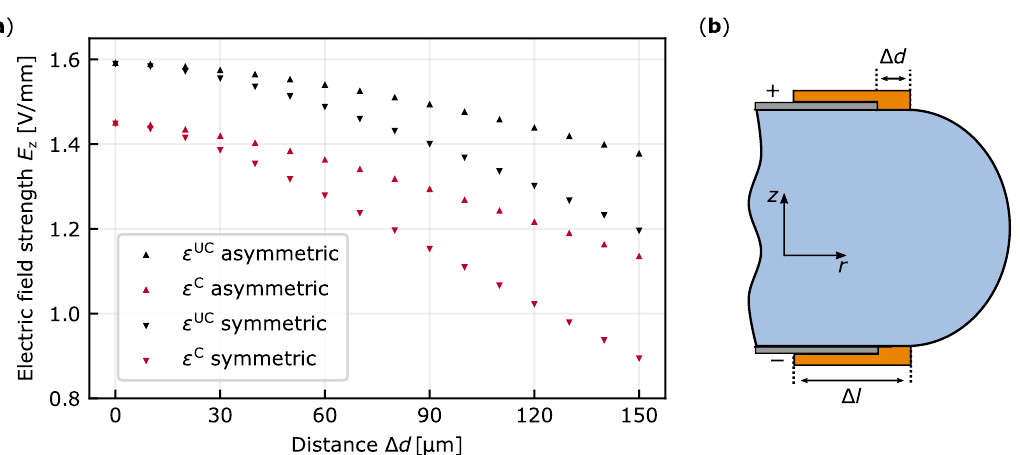
Figure 5. ( a ) The electric field strength in the area of the optical mode for different distances ∆ d of the electrode from the rim of the resonator between 0 and 150µm. The major radius of the WGR is R 1 = 1000µm and the thickness ∆ z = 500µm. ( b ) Schematic of a possible configuration with an additional isolation layer with length ∆ l covering the top and the bottom